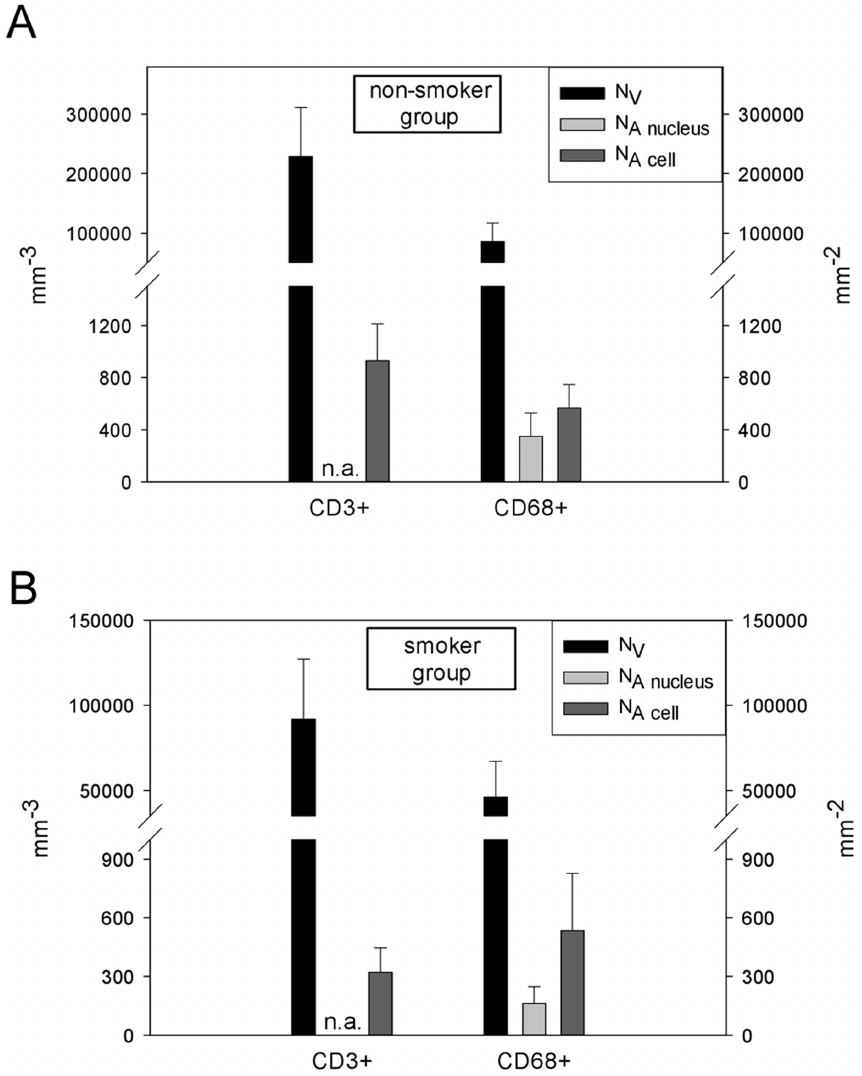
Figure 3. Mean counts per unit volume and area (mean + SD) by group and cell population. doi:10.1371/journal.pone.0092510.g003 PLOS ONE |